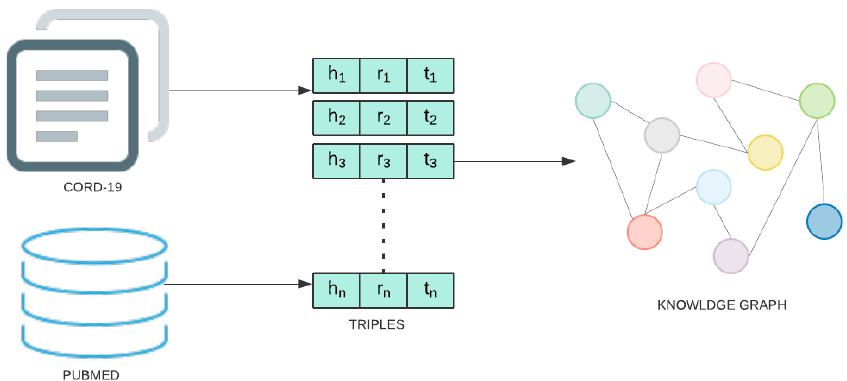
Figure 4. Steps involved in Knowledge graph construction stage.